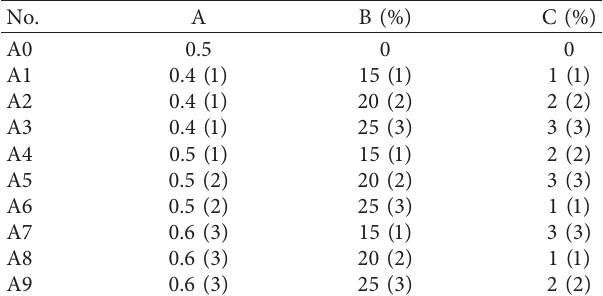
Table 4: Design table for the orthogonal